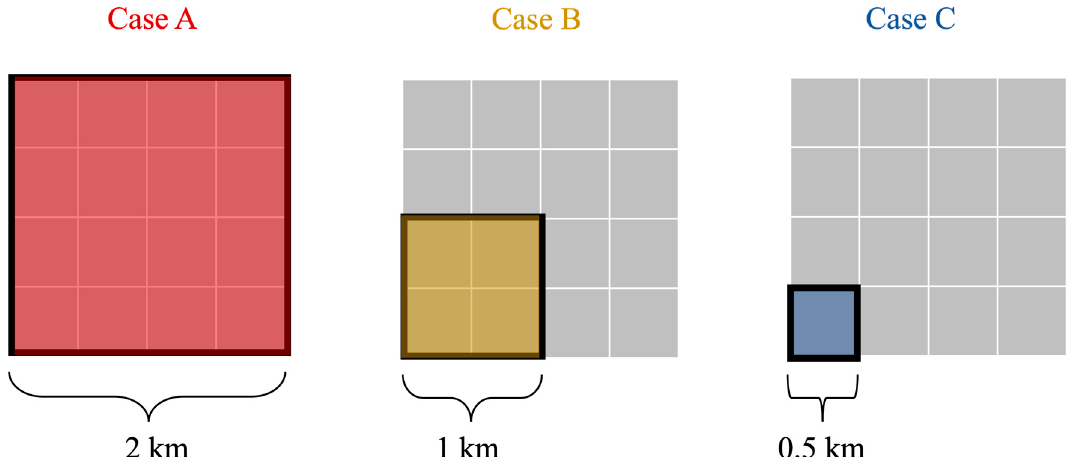
Figure 1. Illustration of three resampling cases. Case A represents averaging all 0.5-km pixels in the 2-km resolution pixel to represent the reflectance in the whole 2-km pixel. Case B represents averaging a block of 4 0.5-km sub-pixels to represent the reflectance in a 1-km pixel, and using that average as the sub-sampled 1-km pixel to represent the 2-km super-pixel reflectance. Case C uses the reflectance in one 0.5-km sub-pixel to represent the reflectance in the whole 2-km super-pixel.